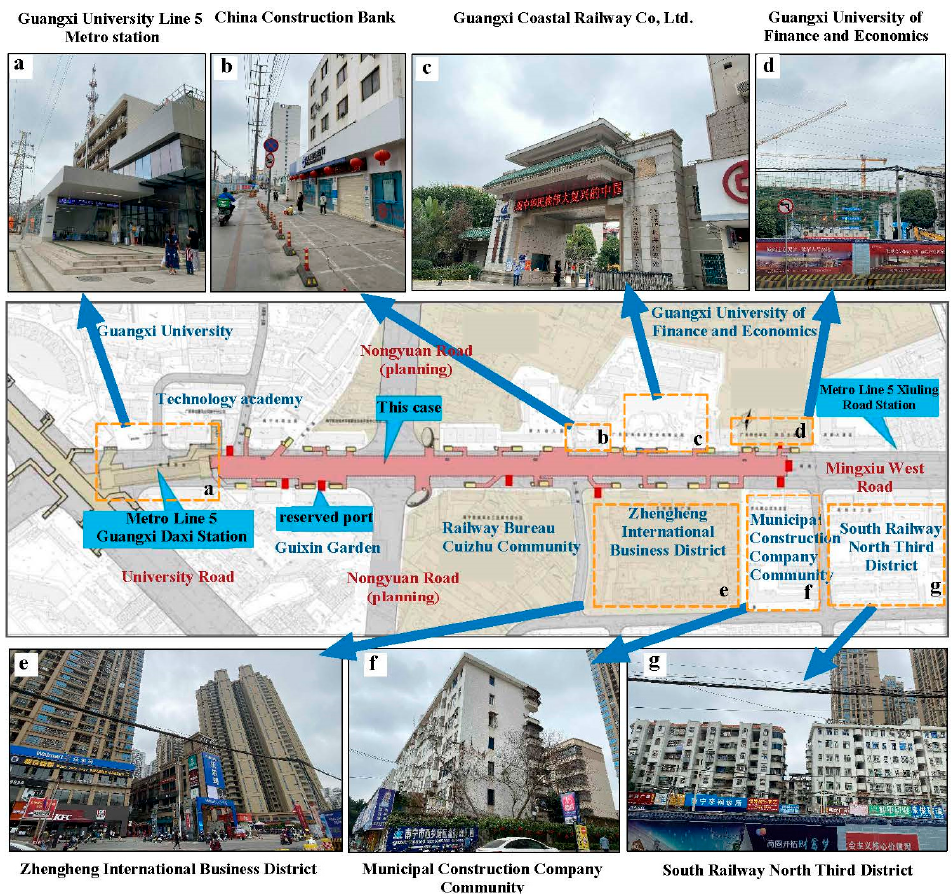
Figure 9. The surrounding buildings and environment of the underground project of Guangxi University of Finance and Economics.